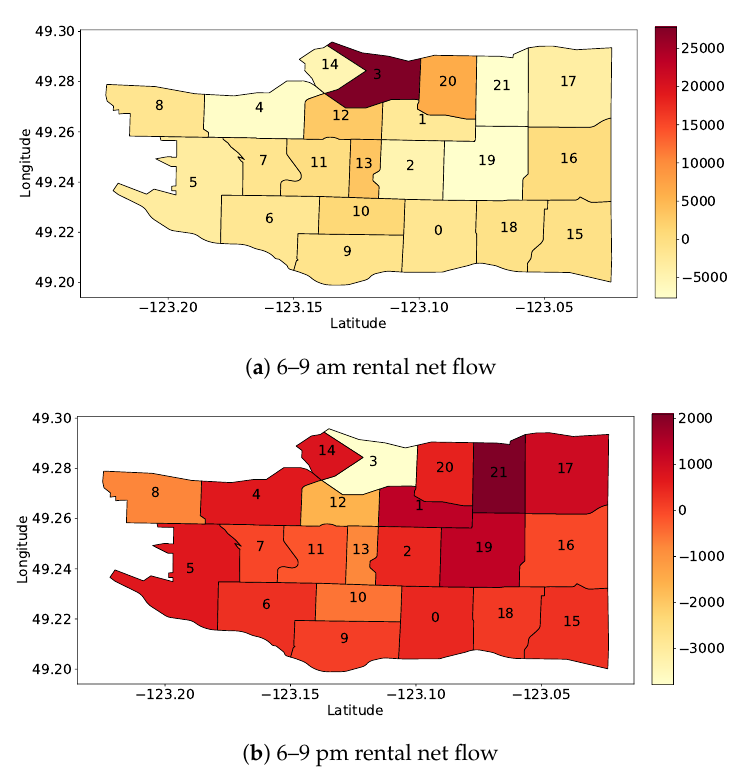
Figure 3. Heatmap of net flow for each neighborhood in Vancouver. The more the area is red, the higher are the arrivals with respect to the departures. Neighborhood numbering is shown (from 0 to 21).